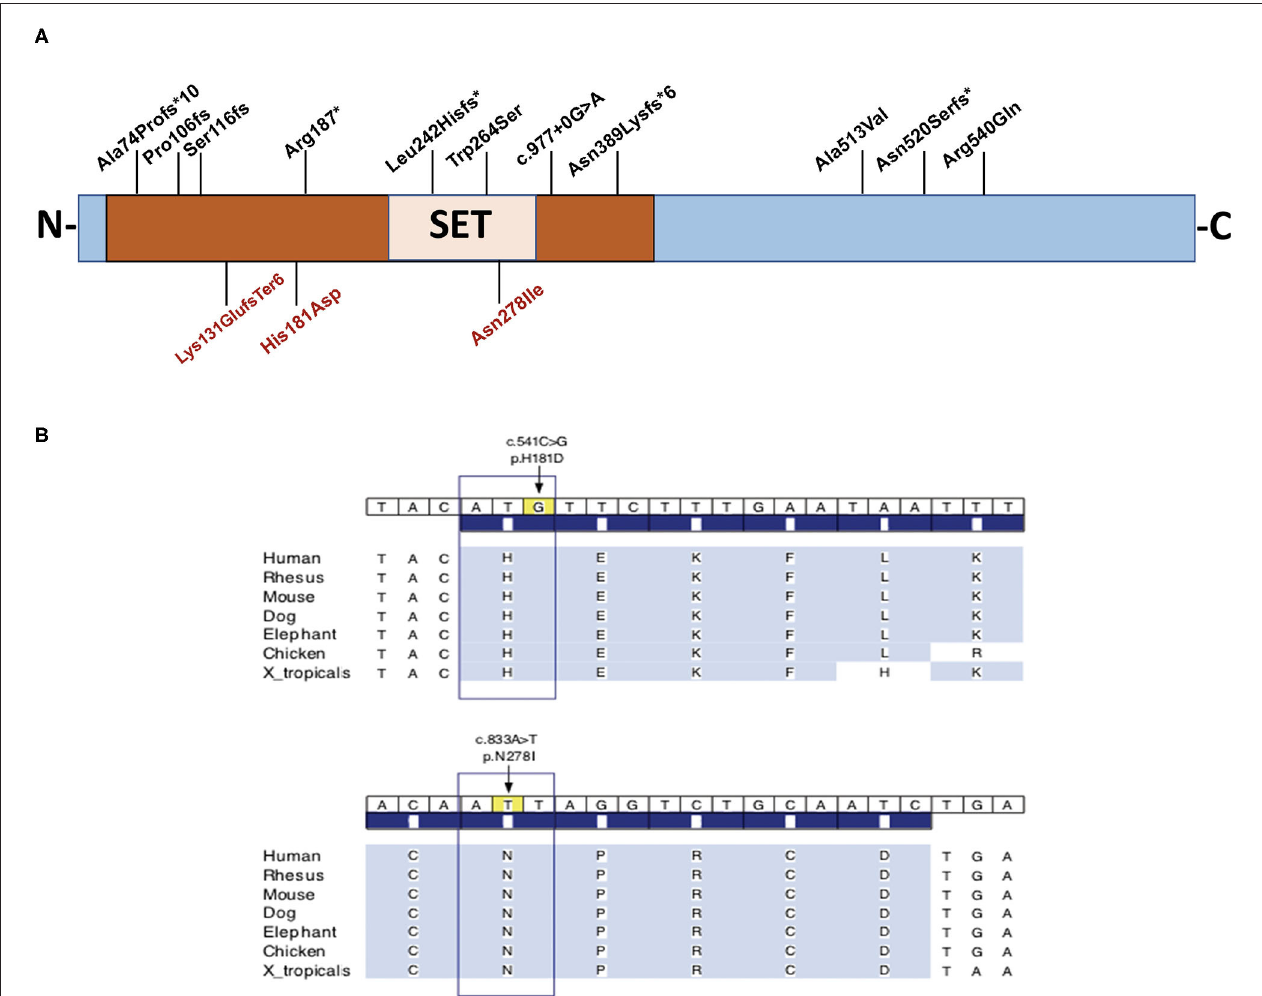
FIGURE 1 | (A) Schematic representation of the full length KMT5B protein and the location of disease-causing variants in three unrelated patients, and all previously-reported patients for whom phenotypic features were available ( n = 14). The variants identified in the three individuals in this report appear on the bottom. (B) Conservation of amino acids H181 and N278 throughout evolution. Brown box designates the functional domain of KMT5B as a histone-lysine